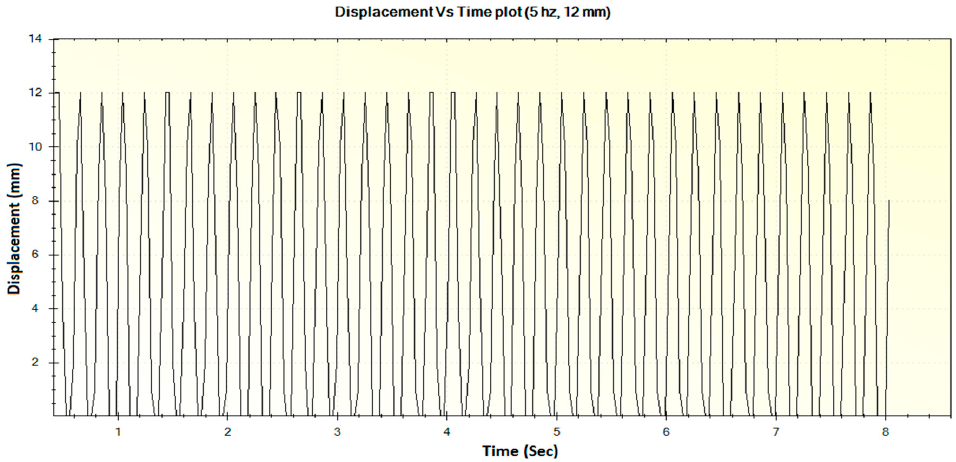
Figure 22. Generated waveform for 5 Hz operation producing a displacement of 12 mm.